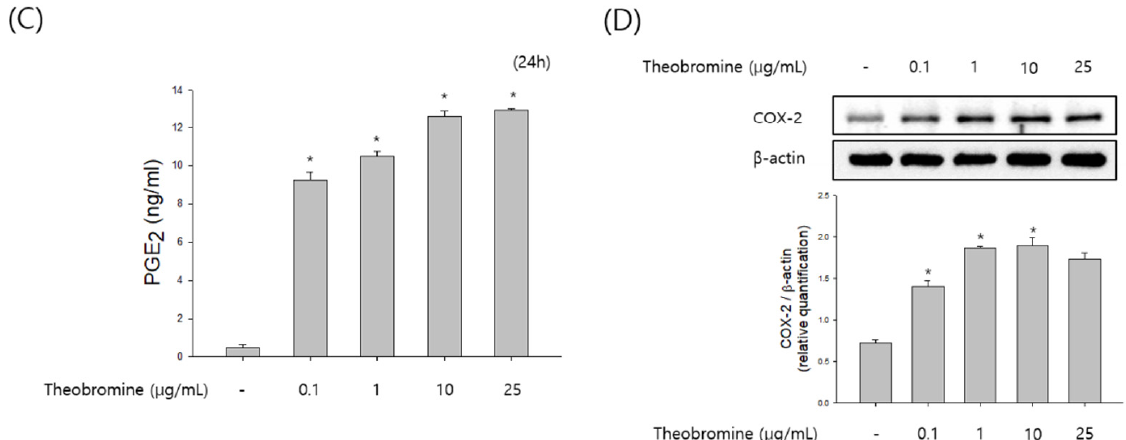
Figure 2. Effect of theobromine on the production of NO and PGE 2 in RAW 264.7 macrophages. Macrophages were treated with different concentrations of theobromine for 24 h. ( A ) Nitrite oxide in the incubated supernatant was determined using the Griess reagent. ( C ) The production of PGE 2 in the culture media was investigated by a ELISA assay kit. The protein expression levels of ( B ) iNOS and ( D ) COX-2 were examined by Western blot assay. β -actin protein levels were used as an internal control. Results are presented as means ± SEM of quintuplicates from a representative ex- periment. * p < 0.05, compared with the untreated group.